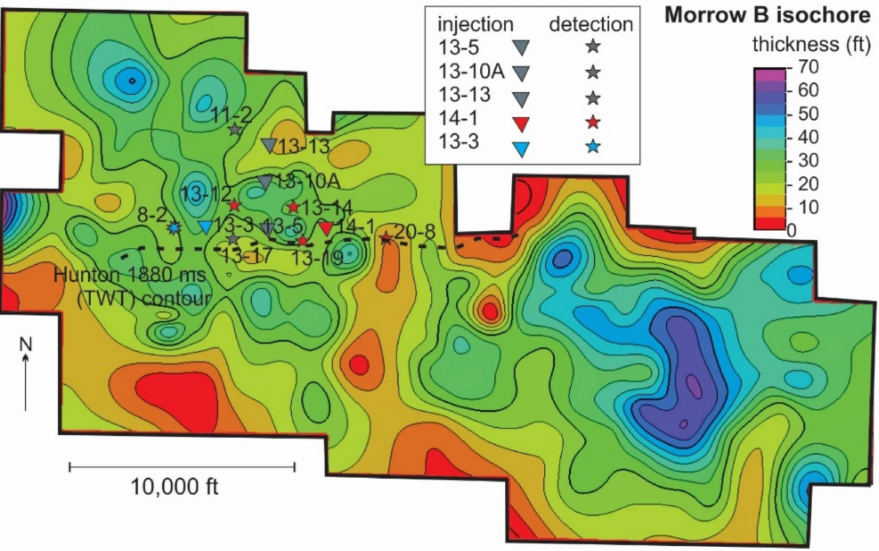
Figure 12. Farnsworth Field map of Morrow B isochore from well logs (well locations shown in White et al., 2017, Figure 3); tracer injection wells (triangles) and detection wells (stars) from tracer studies conducted in 2014, 2015, and 2017 indicated in grey, red, and blue, respectively. Stars mark wells where tracers were detected: injections in 13-13, 13-10A, and 13-5 were detected in 11-2; injections